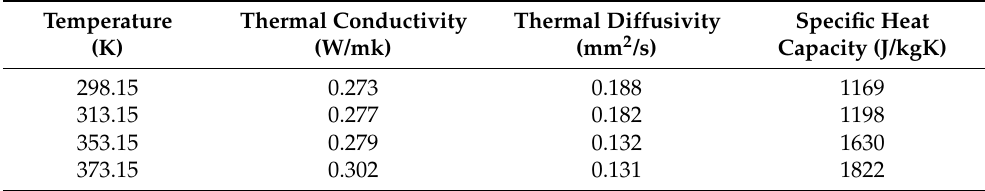
Table 4. Thermophysical properties of PLA/3 wt% GNPs 1 .